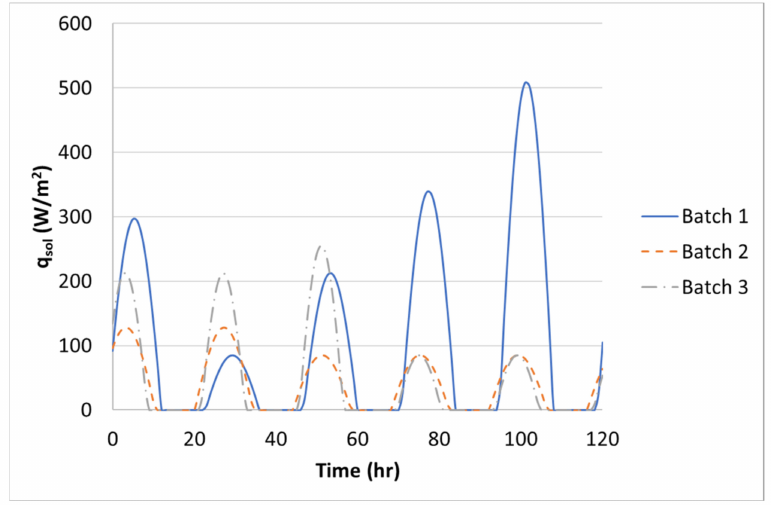
Figure 11. Solar radiation for Batch 1, Batch 2, and Batch 3.